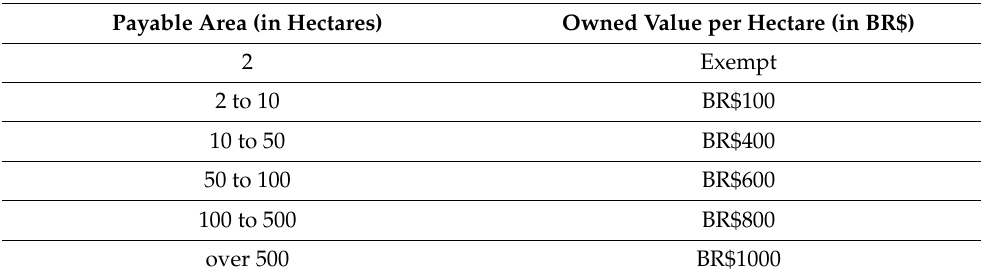
Table 1. Set of fine values for illegal deforestation in Goi á s state, depending on size (hectares), before